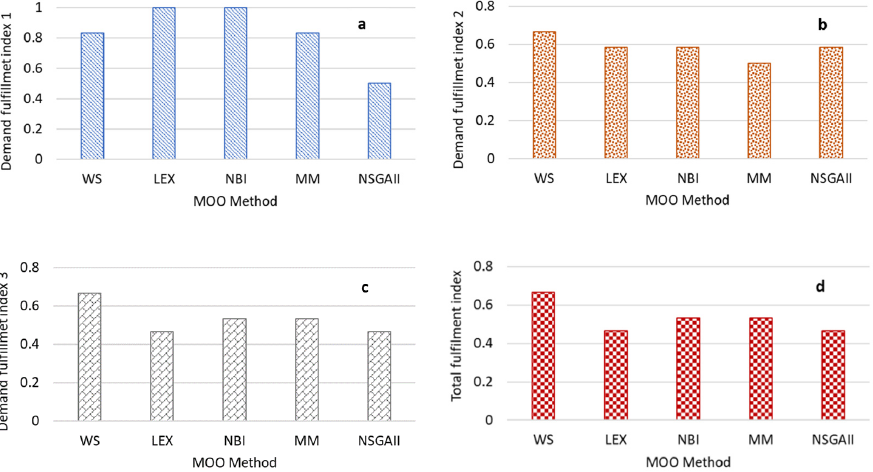
Figure 7. Performance analysis using proposed indices: ( a ) DI 1 ; ( b ) DI 2 ; ( c ) DI 3 ; ( d ) TI.